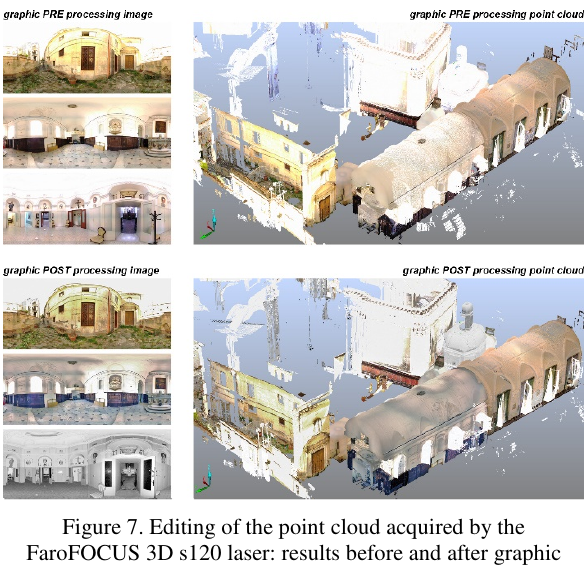
Figure 7. Editing of the point cloud acquired by the FaroFOCUS 3D s120 laser: results before and after graphic correction with the application of color contrast and white